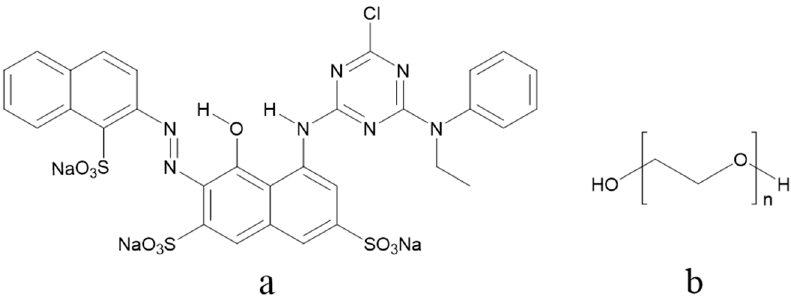
Figure 1. ( a ) Chemical structure of Red 218; ( b ) Chemical structure of polyethylene glycol